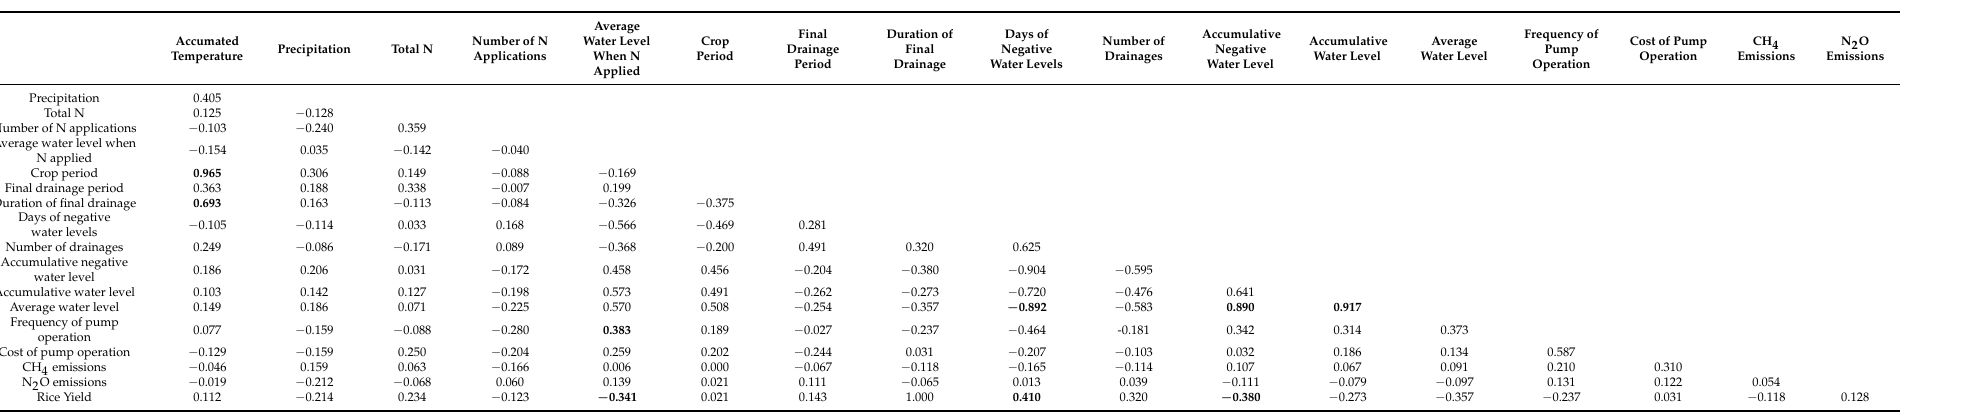
Table 2. Correlation coefficient between the field managements, rice yield, and GHG